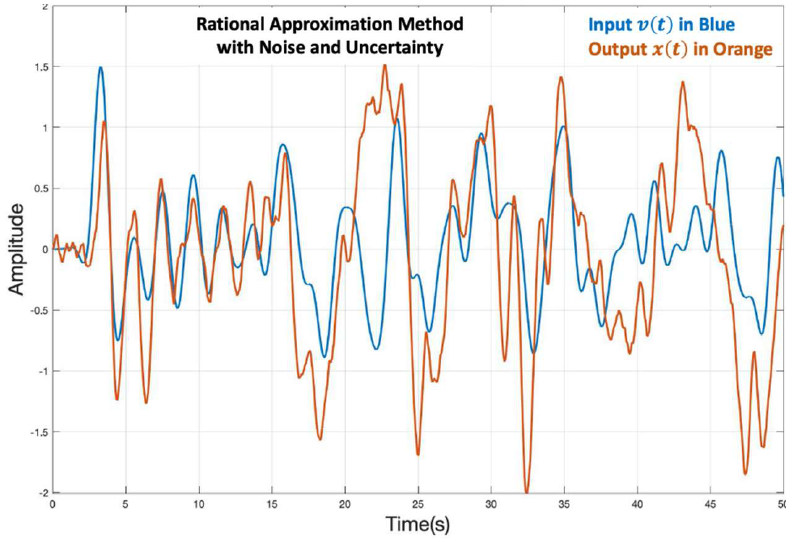
Figure 17. Impact of Noise and Uncertainty (Technique 1).